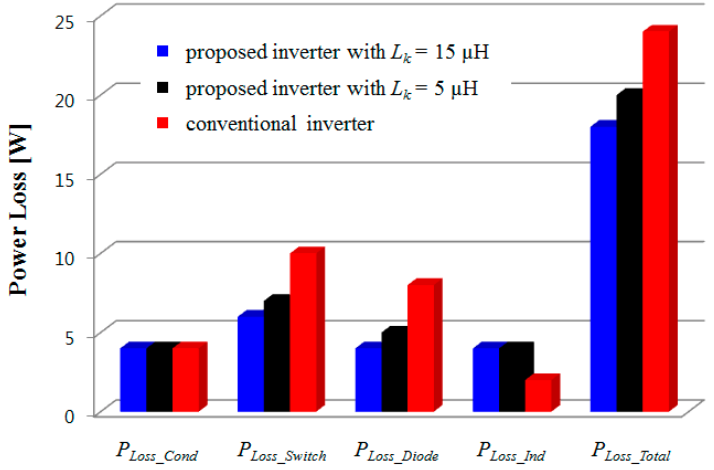
Figure 17. Loss breakdown plots of the inverters for a 1.0 kW output power.